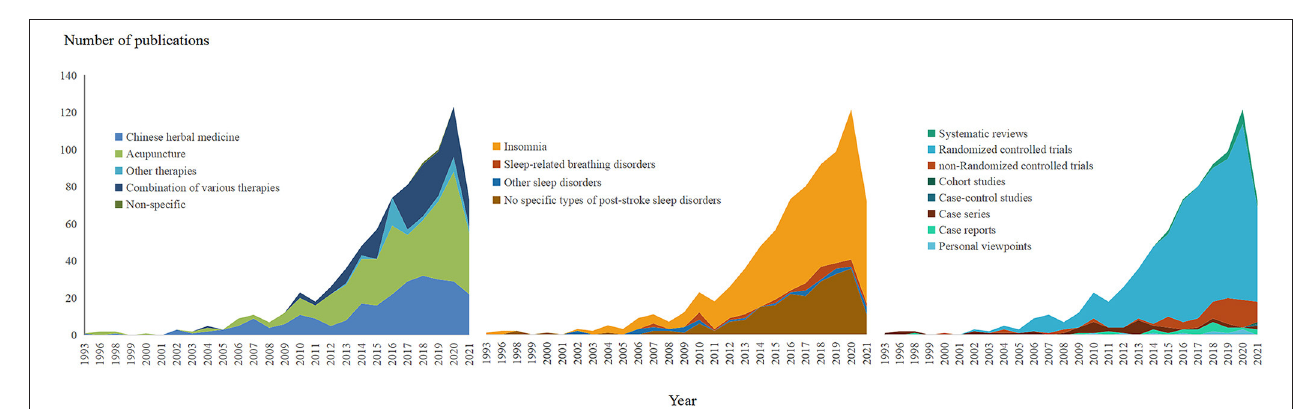
FIGURE 3 | The time-dependent changes of publications on traditional Chinese medicine for post-stroke sleep